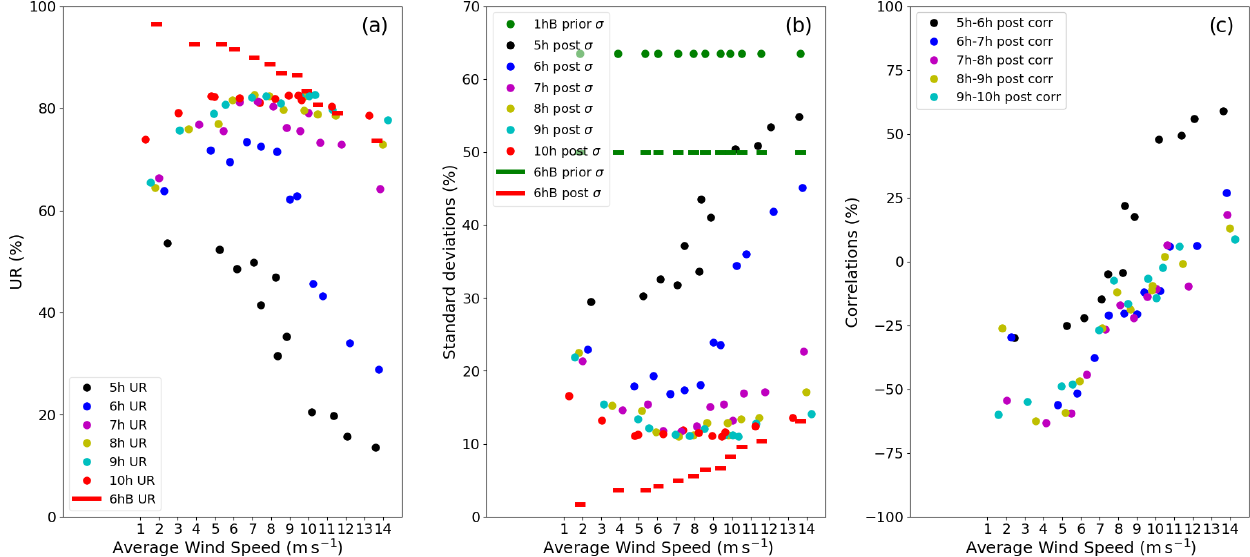
Figure 3. Uncertainty reductions (UR) from a 50% prior uncertainty on the 6h budgets of the Paris emissions for 12d characterized by different average wind speeds over Paris (a) . The UR for hourly and 6h budgets of the Paris emissions are shown using colored dots and red segments, respectively. In panel (b) , the prior vs. posterior uncertainties on 1h emissions (colored dots) and 6h emissions (green and red segments) of Paris are shown. In panels (a) and (b) , the colors of the dots represent the hour of the corresponding 1h budget; the green dots represent the prior uncertainties on the 1h emissions (1hB prior σ ) which are derived from 50% prior errors on the 6h budgets (6hB prior σ) and by considering temporal prior correlations of 3h. Panel (c) shows correlations between posterior uncertainties in two consecutive 1h emissions (colored dots). Results are computed with a retrieval resolution of 2km × 2km, a precision of 0.6ppm and a swath of 300km.